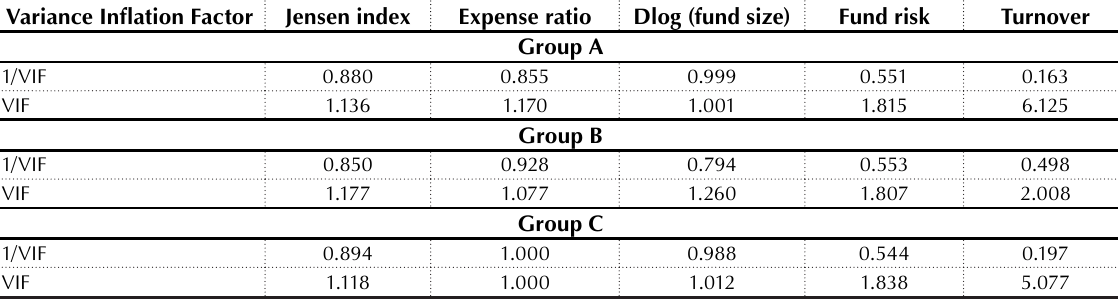
Table 8. Variance Inflation Factor